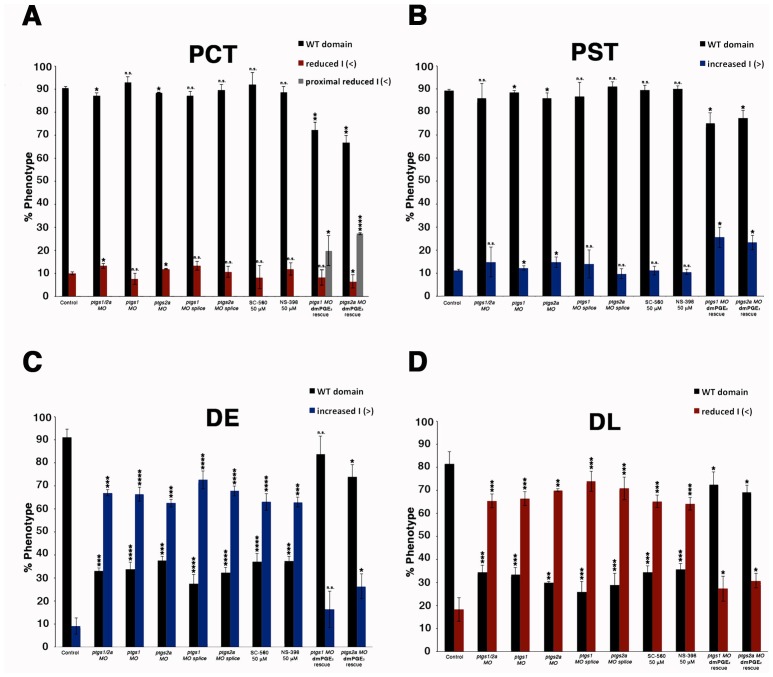
Diminishing Ptgs1 or Ptgs2a function causes distal early cell-fate identity to be favored at the expense of the distal late domain.(A) The PCT, (B) PST, (C) DE, and (D) DL segment phenotypes were quantified in triplicate at the 24 hpf stage according to comparisons to the somites for ptgs1/2a double MO, ptgs1 MO, ptgs2a MO, ptgs1 splice MO, and ptgs2a splice MO microinjections, SC-560 and NS-398 at 50 μM from 4 hpf to 24 hpf, and for embryos microinjected with either ptgs1 MO or ptgs2a MO and treated with dmPGE2 at 50 μM from 4 hpf to 24 hpf. Greater than (>) and less than (<) were used to categorize embryos, where each (>) or (<) represents the difference of a somite change in segmentation. At least 15 embryos were used per control and experimental group. Data are represented as ± SD significant by t test comparing each drug treatment to the corresponding DMSO control group, *p<0.05, **p<0.005, ***p<0.0005, ****p<0.00005, where n.s. indicates not significant.